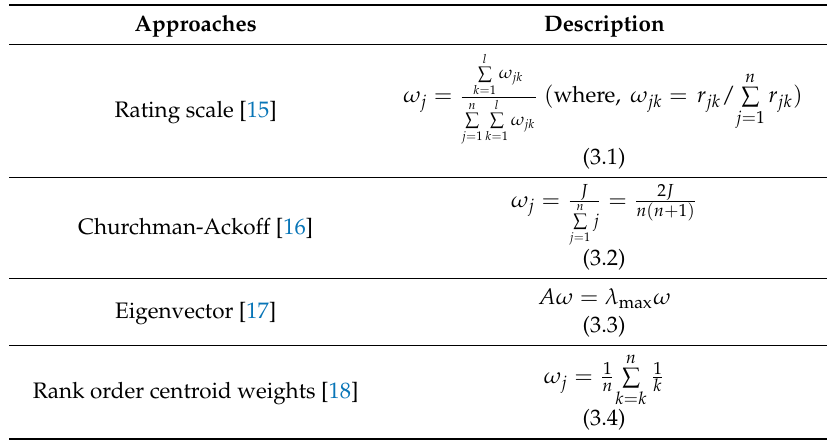
Table 3. Determination weight factor approaches.